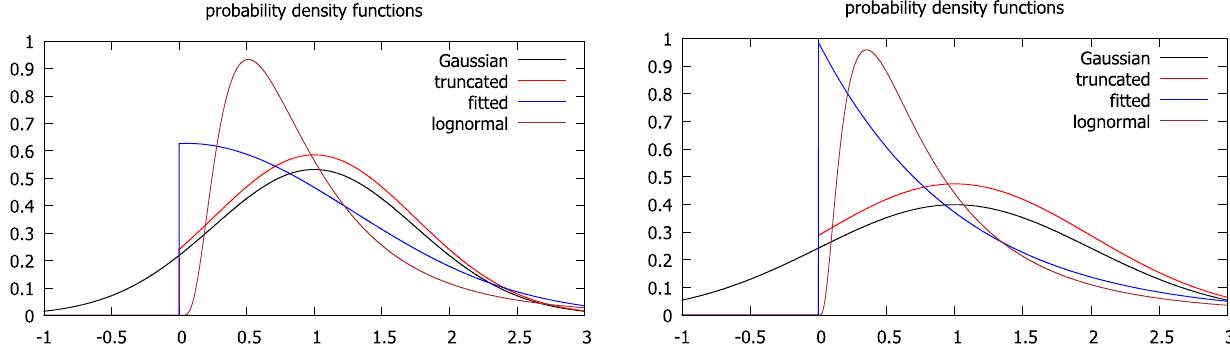
Fig. 6. Candidate law probability density function for relative standard deviation of 75% (left) and 100%